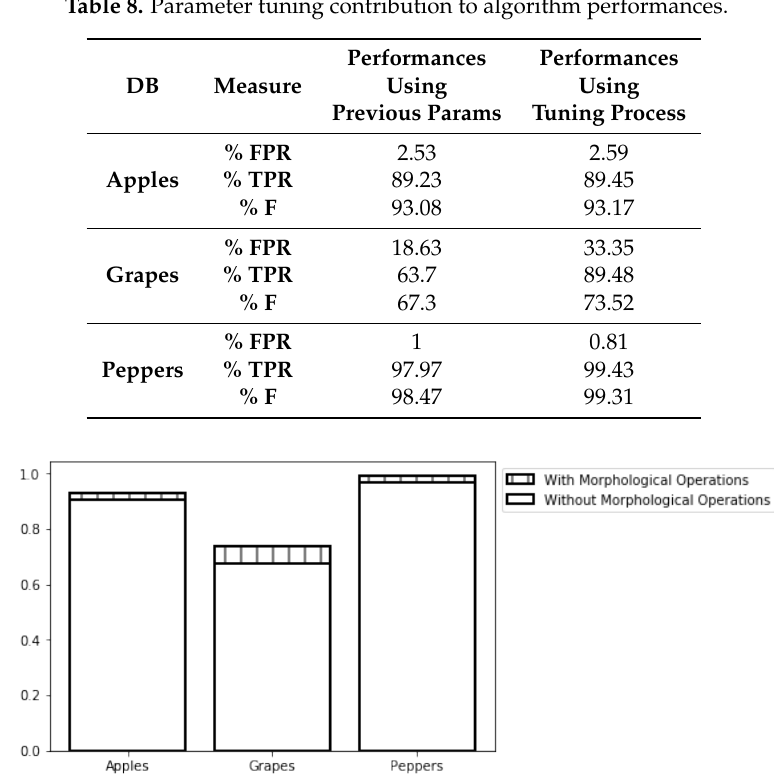
Figure 17. Sensitivity analysis: adding noise to the STD stop